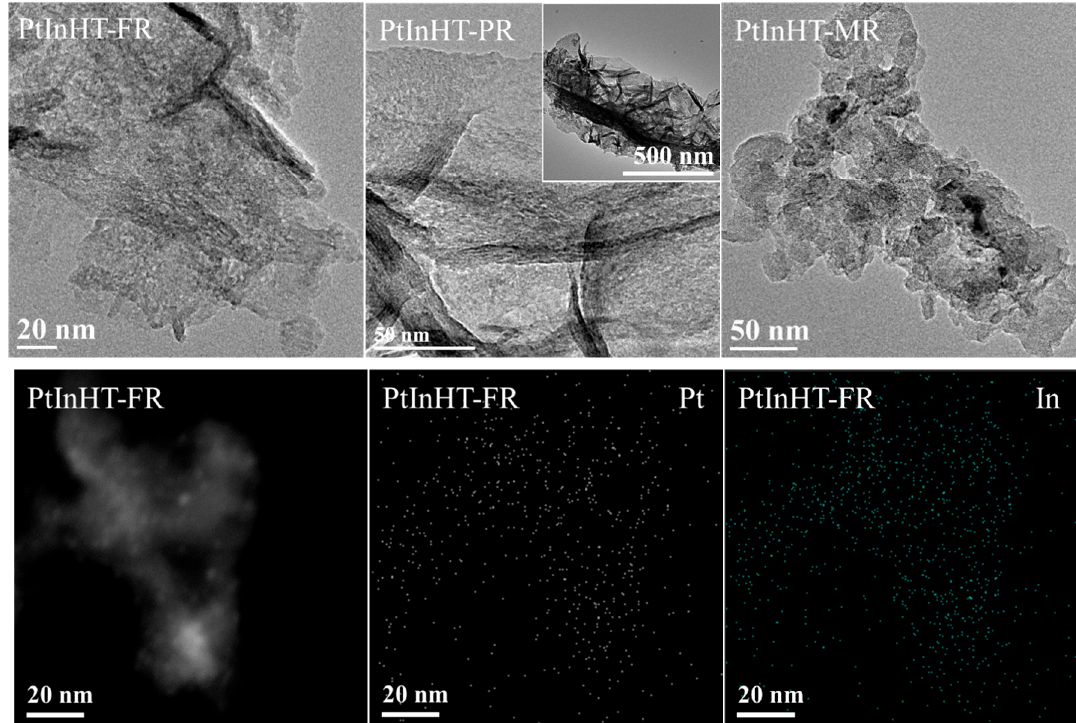
Figure 2. TEM images of reduced samples: PtInHT-FR, PtInHT-PR, PtInHT-MR and EDS element-mapping analysis of PtInHT-FR. In the abbreviations: F—flower-like, P—single-plate, and M—block mass and R—reduced sample.